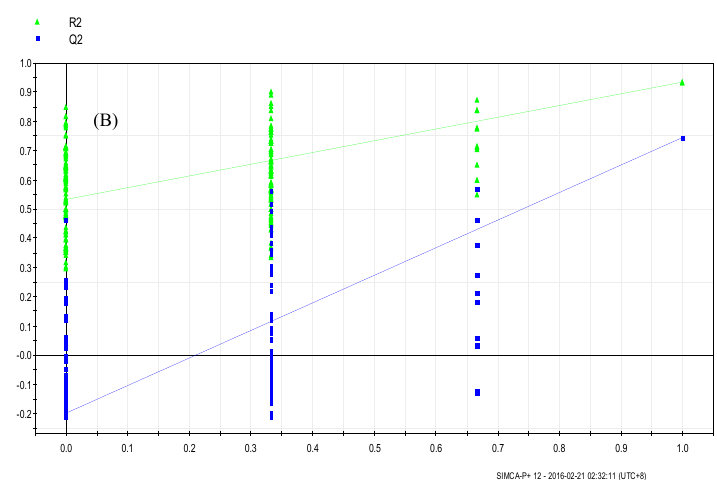
Figure 6. Permutation test of RAW264.7 cells from treatment and control groups. ( A ) LPS and control groups ( B ) SPPM60-Dand control groups.